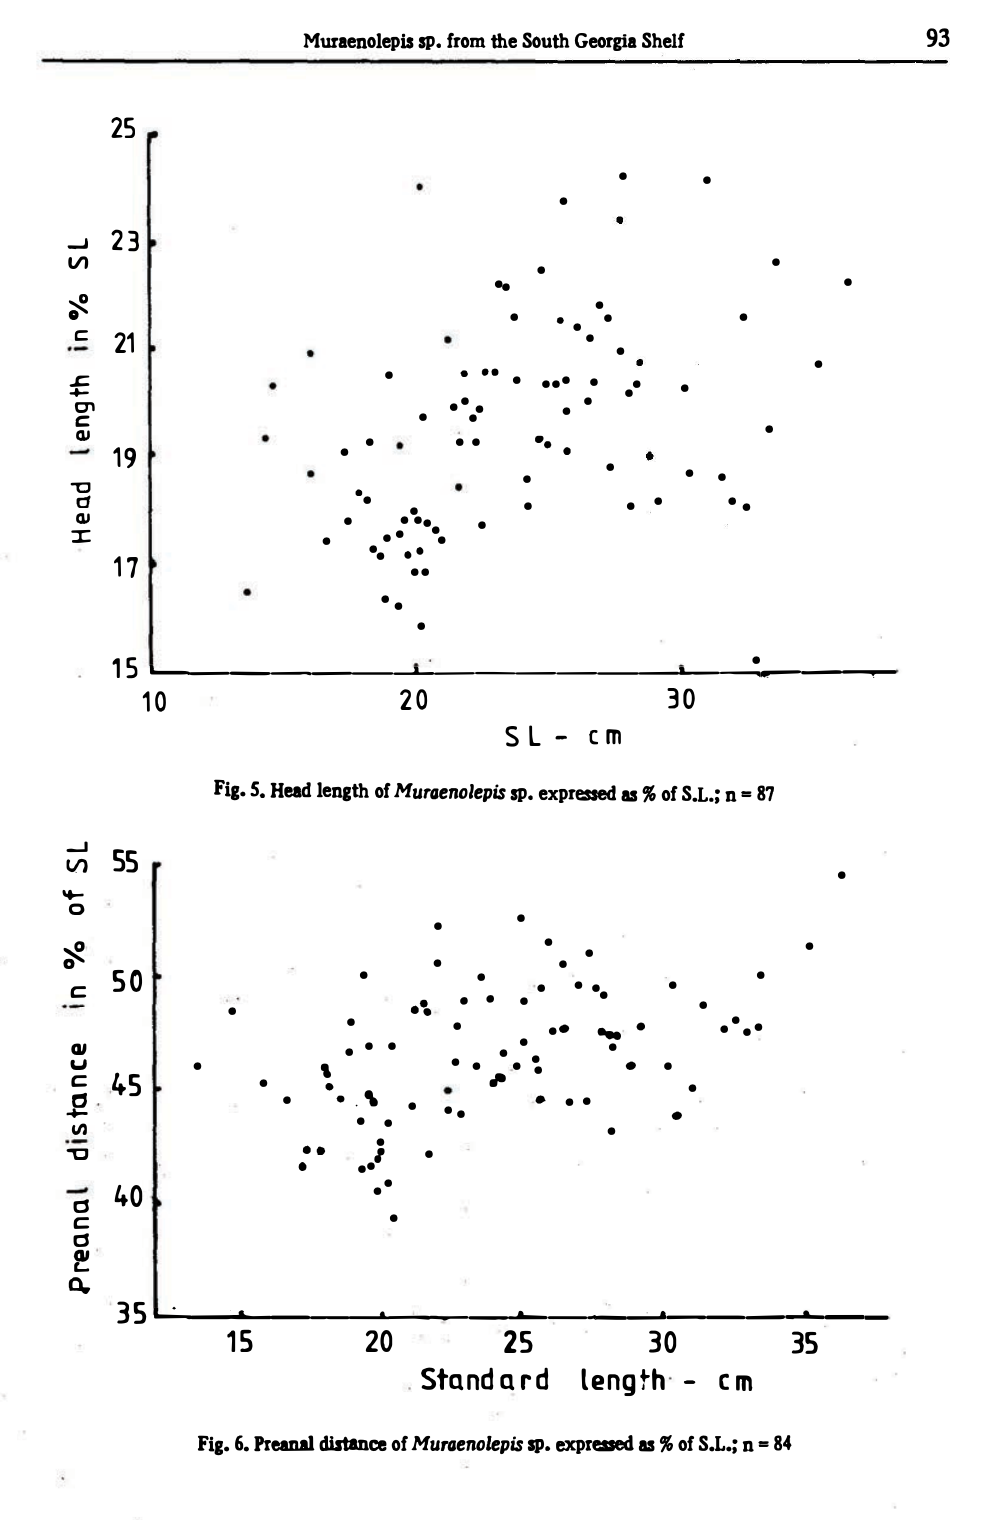
Fig. 6. Preanal distance of Muraenolepis sP· expressed as % of S.L.; n =